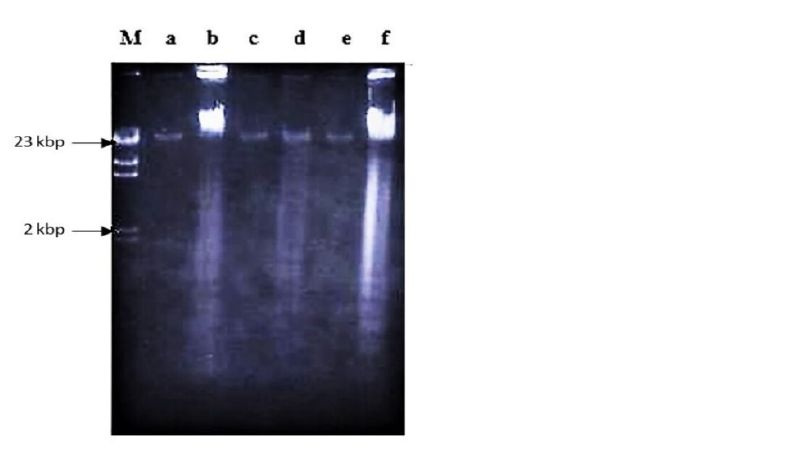
Figure 4. The involvement of Ca 2+ /Mg 2+ -dependent endonuclease and protein synthesis in nordamnacanthal-induced apoptosis in CEM-SS cells at 24 h. Zinc sulphate and cycloheximide failed to prevent apoptosis induced by 10 μg/mL of nordamnacanthal at 24 h. Lane a: control. Lane b: nordamnacanthal (10 μg/mL). Lane c: zinc sulphate (0.1 mM). Lane d: nordamnacanthal (10 μg/mL) + zinc sulphate (0.1 mM). Lane e: cycloheximide (10 μg/mL). Lane f: nordamnacanthal (10 μg/mL) + cycloheximide (10 μg/mL). Lane M: Marker (HindIII digest of lambda DNA).